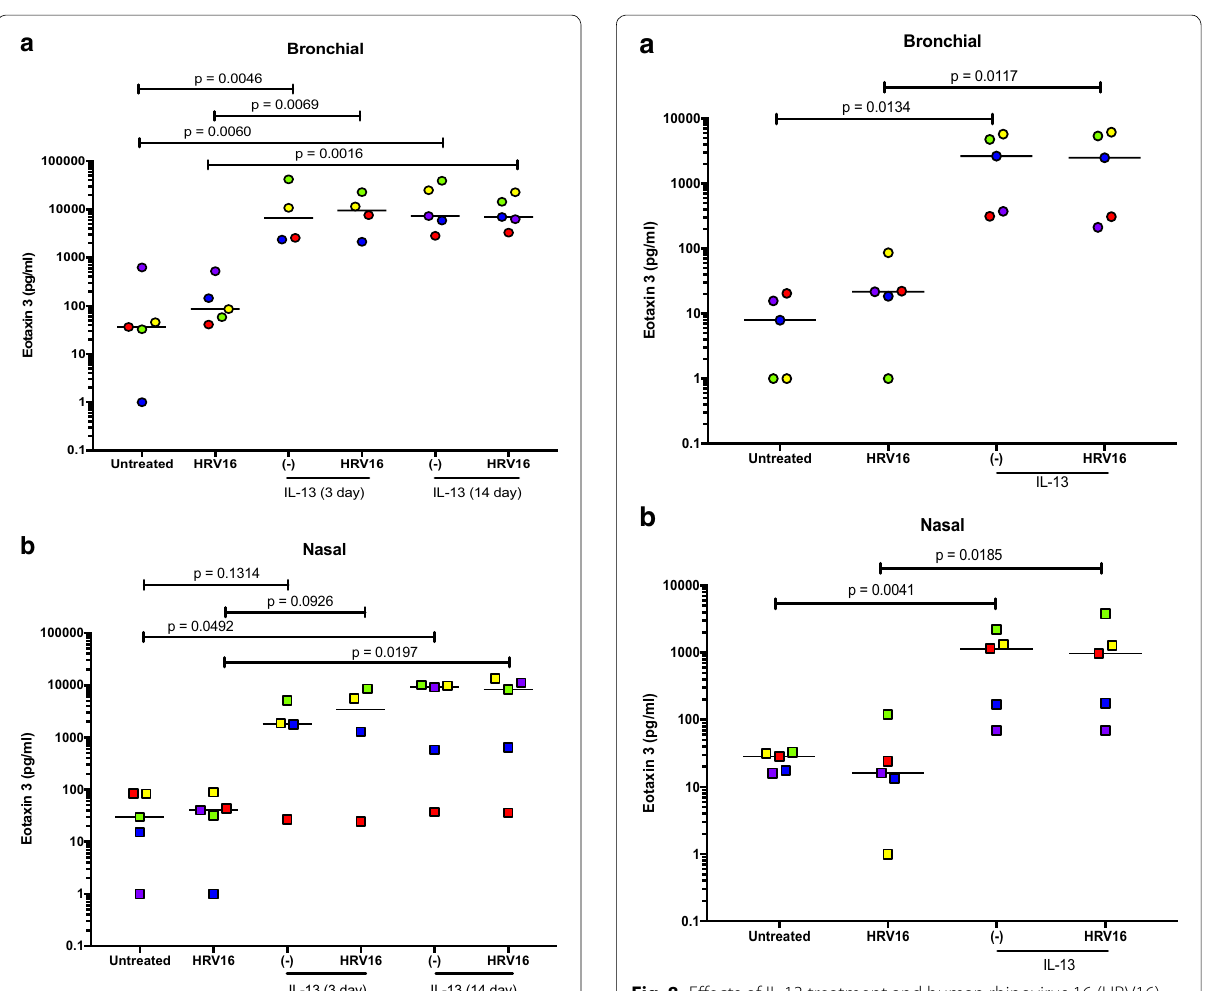
Fig. 8 Effects of IL-13 treatment and human rhinovirus 16 (HRV16) infection on eotaxin 3 production paired human primary bronchial Fig. 7 Effects of IL-13 treatment and human rhinovirus 16 (HRV16) ( a ) and nasal ( b ) epithelial cells under the submerged culture. Each of infection on eotaxin 3 production in air–liquid interface (ALI) cultures the colored solid circles (n 5 subjects) represents the data from an of paired human primary bronchial ( a ) and nasal ( b ) epithelial cells. = individual subject. The horizontal lines indicate Each of the colored solid circles (n 4 to 5 subjects) represents the = data from an individual subject. The horizontal lines indicate medians